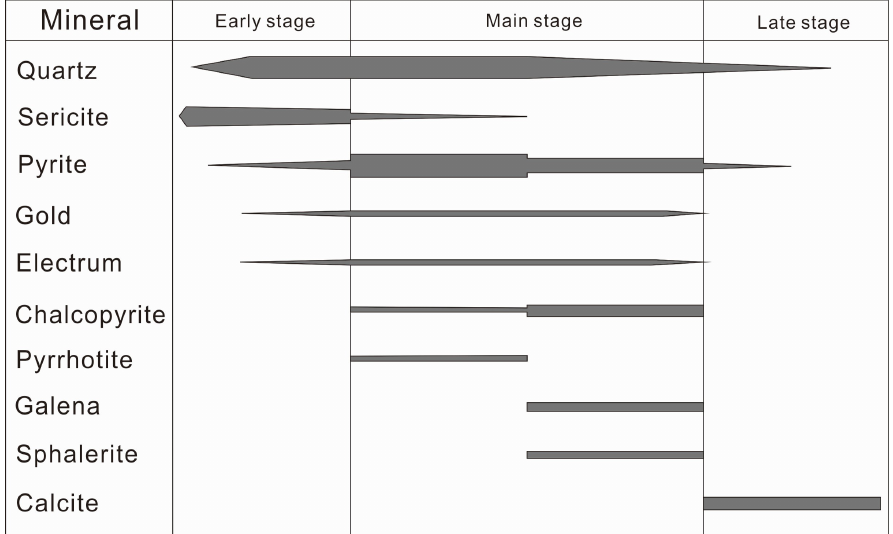
Figure 7. The paragenetic sequence of the hydrothermal alteration and mineralization at the Sizhuang gold deposit interpreted by crosscutting relationships and assemblages of minerals: The thickness means the abundance of minerals in the paragenetic sequence.